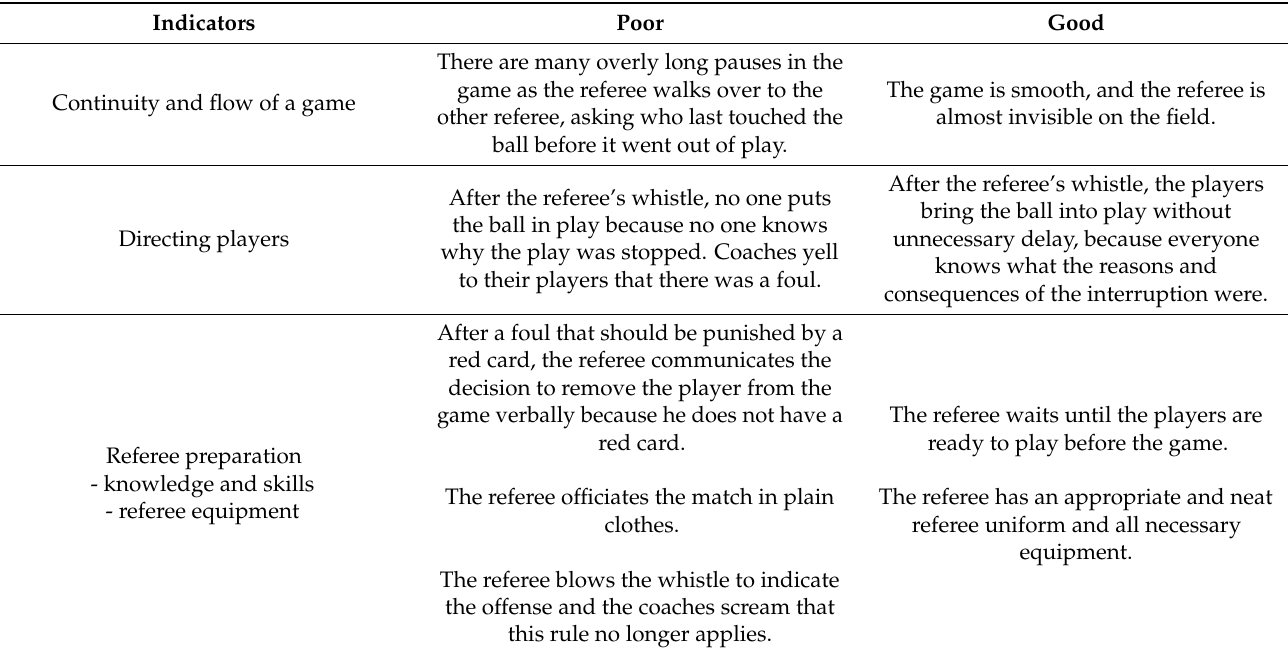
Table 3. Examples of low-quality and high-quality interactions in the dimension of proficiency